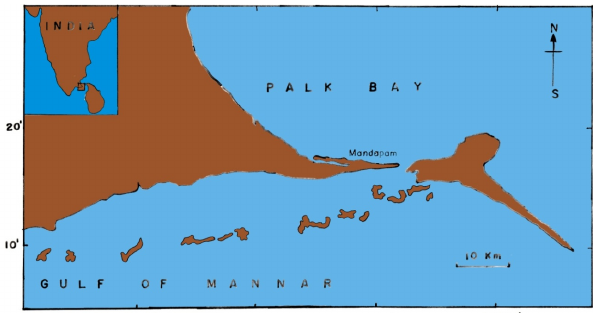
Fig. 1. Map showing the location of sampling site (Mandapam, Palk Bay)